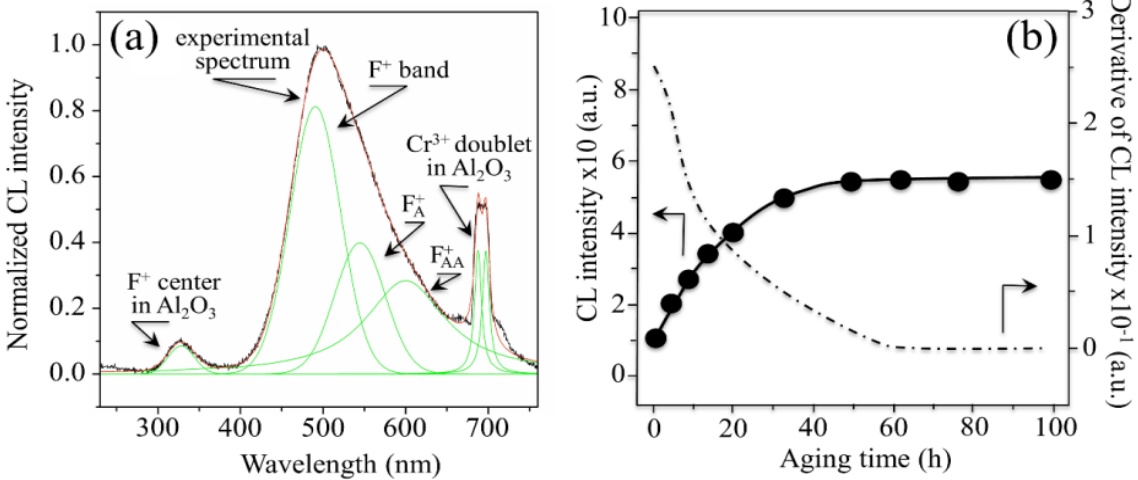
Figure 3. ( a ) Typical CL spectrum of biomedical 3Y-TZP. Three distinct emissions from oxygen-related defects with different structures overlap in the CL spectrum of ZrO namely the bands referred to F + , F A+ , and F AA+ centers. Two extrinsic CL emissions also